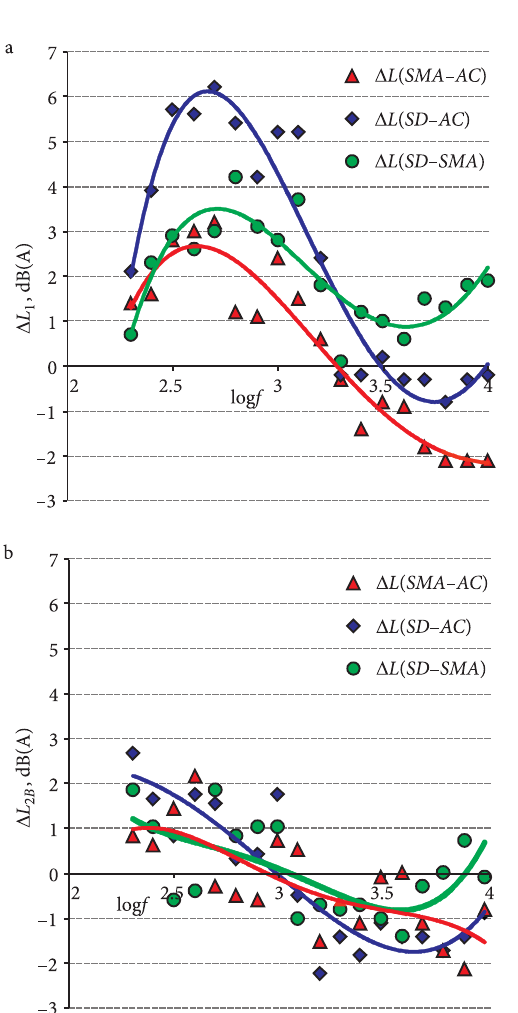
Fig. 4. Values of differences between levels of rolling passenger car noise (a) and heavy vehicle category 2B (b) in the third- octave band spectra on three tested